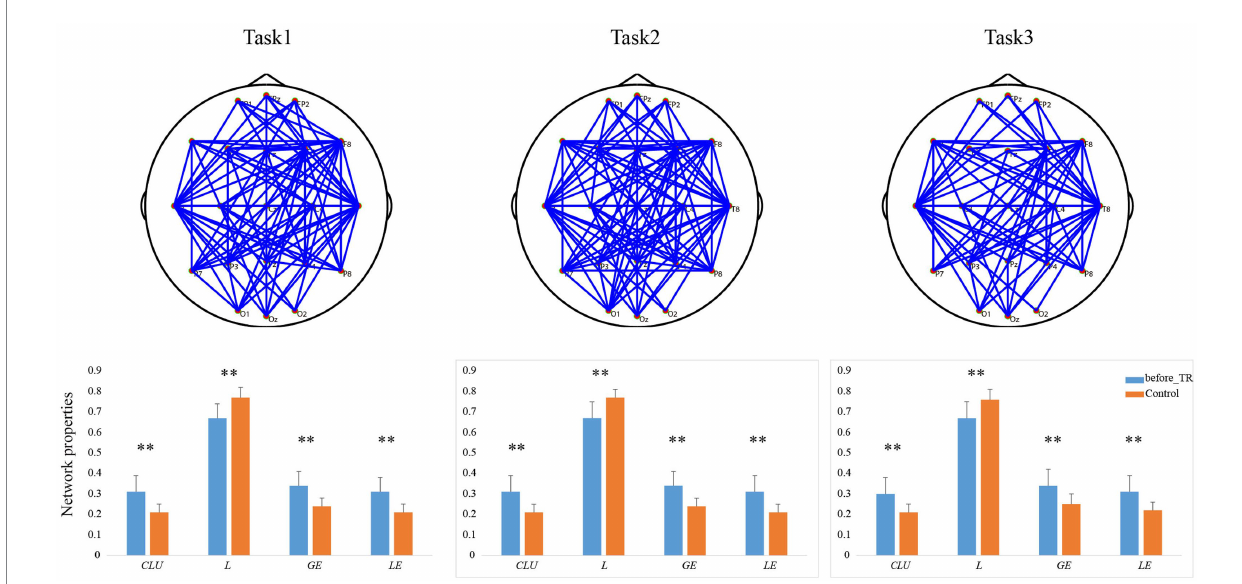
FIGURE 2 The first line is network topology differences between the before_TR group and the control group in the cool executive tasks (Task 1: THT; Task 2: TMT-A; Task 3: TMT-B). The corresponding network properties in the three tasks were below the network topologies. ** indicates p < 0.01. The blue solid lines denote the stronger network edges ( p < 0.05, FDR corrected) of the before_TR group compared to those of the control group.